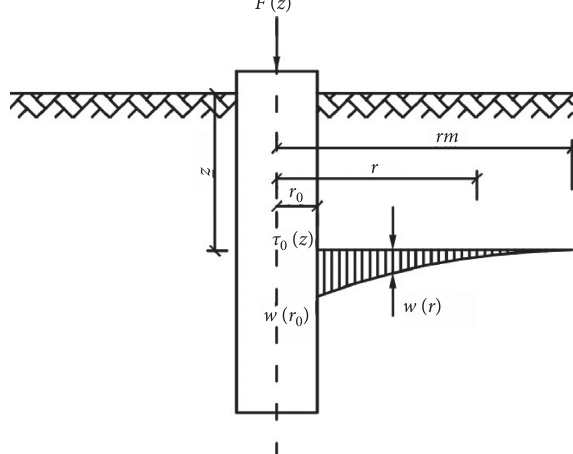
Figure 1: Pile-soil shear displacement